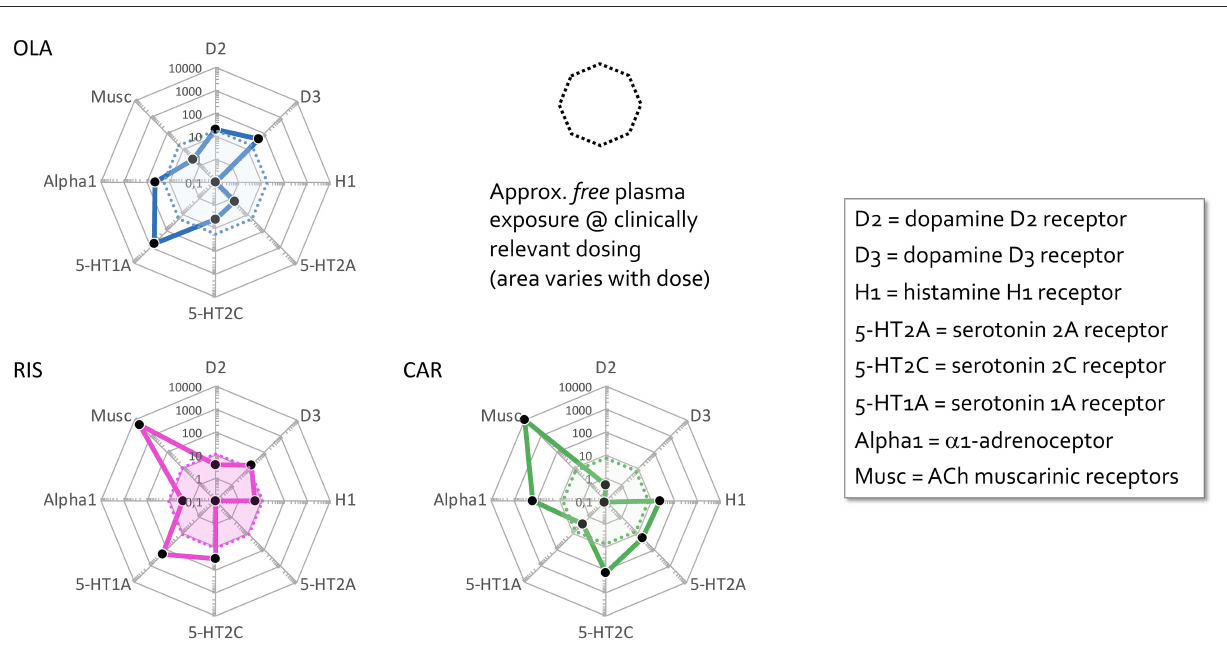
FIGURE2 Comparative pharmacodynamic profiles of antipsychotic agents used by the patient. “Cobweb” depiction of pharmacodynamic target profiles of risperidone (RIS), olanzapine (OLA), and cariprazine (CAR) overlaid on the corresponding free (unbound) steady-state plasma concentrations (nmol/L) of these antipsychotics at average clinical dosage (RIS, pink area; OLA, blue area; CAR, green area). Black dots correspond to drug affinities reported in the literature (in nM) for the targets labeled on the edges of the cobweb; the closer to the center, the higher affinity for the target in question. The drug cobweb profiles in this figure were compiled from data in public web databases and complementary literature, including drug SPC’s; viz . human (cloned or native tissue) receptor affinities (4–6); therapeutic steady-state exposures (7); free fraction of drug plasma concentrations (8). Therapeutic steady-state exposure areas shown were obtained by converting ng/mL (7) to nM, and multiplying by the free fraction in plasma (8) for the corresponding drug [For further detail, see